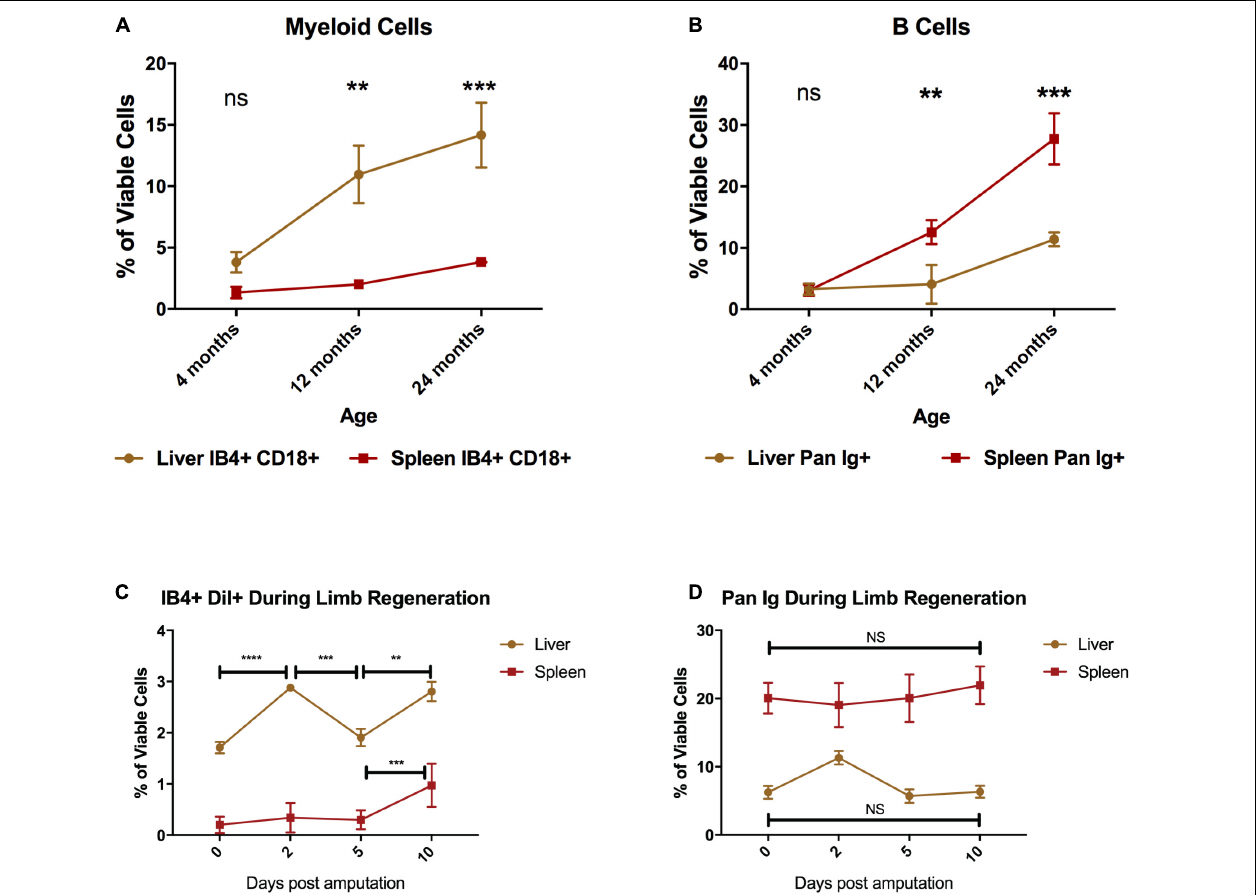
FIGURE 5 | Liver and spleen identification of the major leukocyte subsets in the axolotl liver and spleen throughout its lifespan. (A) Line graph of percentage of myeloid cells (IB4 + CD18 + ) in the liver (brown) and spleen (red) prior to sexual maturity (4 months), sexual maturity (12 months), and thymic involution (24 months). (B) Line graph of percentage of B cells (Pan Ig + ) in the liver (brown) and spleen (red). Graphs show mean ± SEM of three biological samples at each time point. Adjusted p-values obtained via 2-way ANOVA with multiple comparisons to the 4-month-old sample. *** p ≤ 0.01, *** p ≤ 0.001 (C) Line graph showing changes in mature phagocyte number (IB4 + DiI + cells) measured by flow cytometry in the liver (brown line) and spleen (red line) over the course of early limb regeneration. (D) Line graph showing changes in B cell numbers measured by flow cytometry in the liver (brown) and spleen (red) over the course of early limb regeneration. Error bars represent mean ± SEM of three animals per group at each time point. Adjusted p -values obtained via one-way ANOVA with multiple comparisons within each group. ** p ≤ 0.01, *** p ≤ 0.001, **** p ≤ 0.0001. ns, not